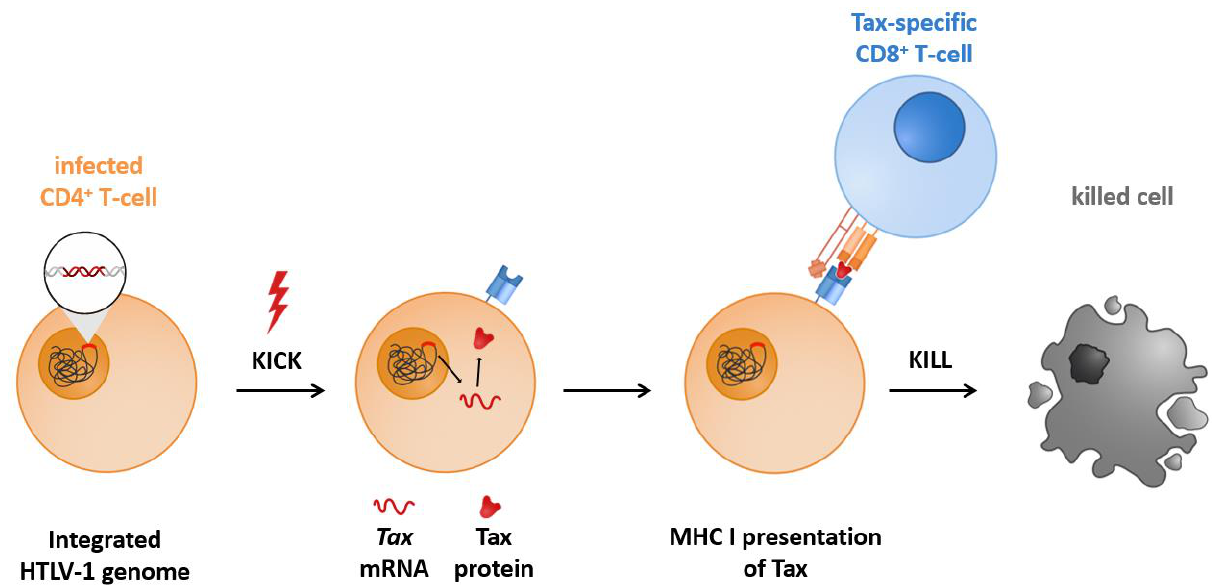
Figure 1. The Kick and Kill approach. The Kick and Kill approach presents a treatment option for HTLV-1 infection with the objective to eliminate the CD4 + T-cells latently infected with HTLV-1. The “KICK” aims to reactivate viral transcription. Consequently, the immunodominant protein Tax will be presented via MHCI on latently infected cells. CD8 + T-cells will mediate the “KILL” of this latent viral reservoir. Abbreviations: CD, cluster of differentiation; HTLV-1, human T-cell leukemia virus type 1; MHC I, major histocompatibility complex class